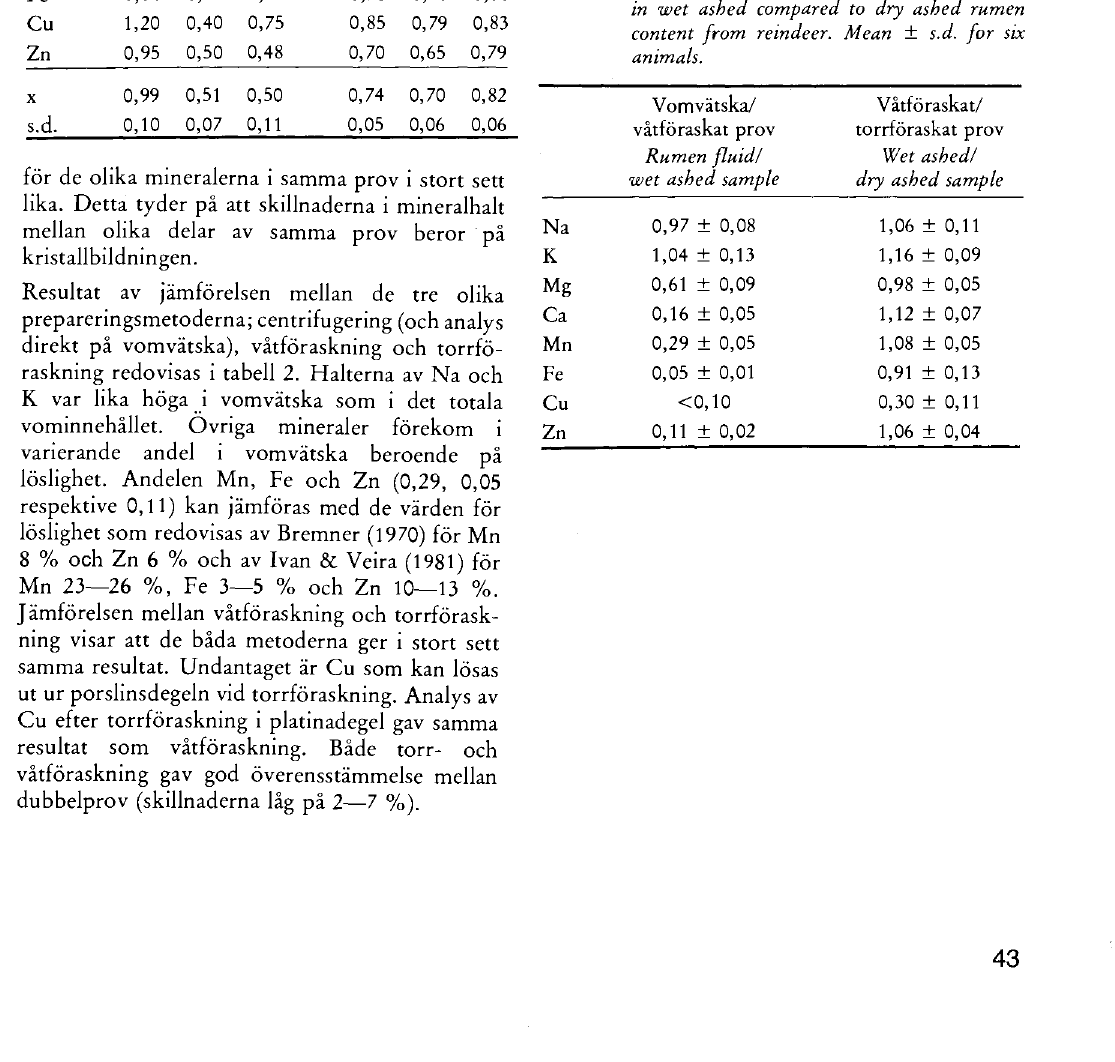
Table 1. Relative concentrations of minerals in upper compared to lower part of centrifuged (at 1800 g for 60 min) samples of earlier frozen rumen and caecum fluid from reindeer. Vomvätsk a